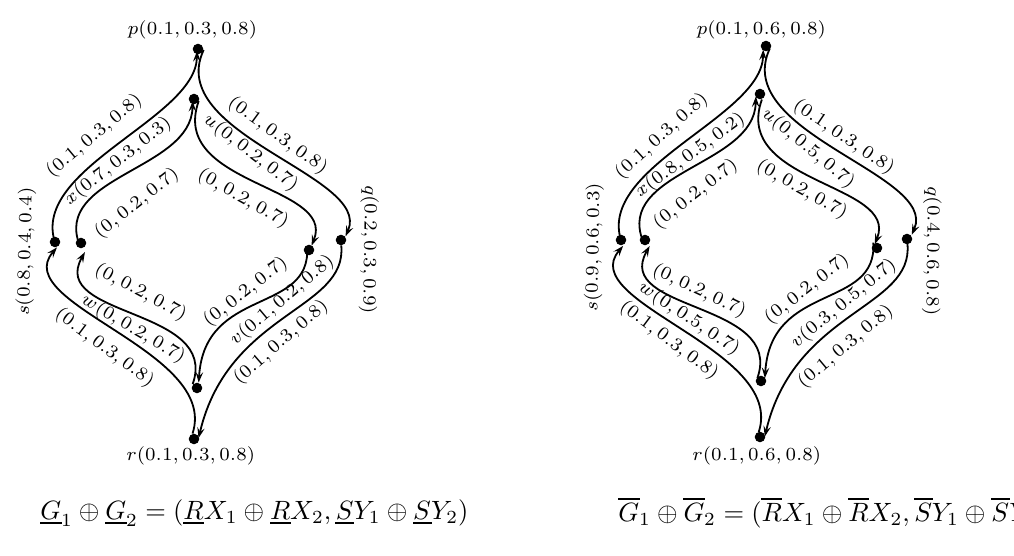
Figure 7: Neutrosophic Rough Digraph G = ( G Figure 7. Neutrosophic rough digraph G = ( G 1